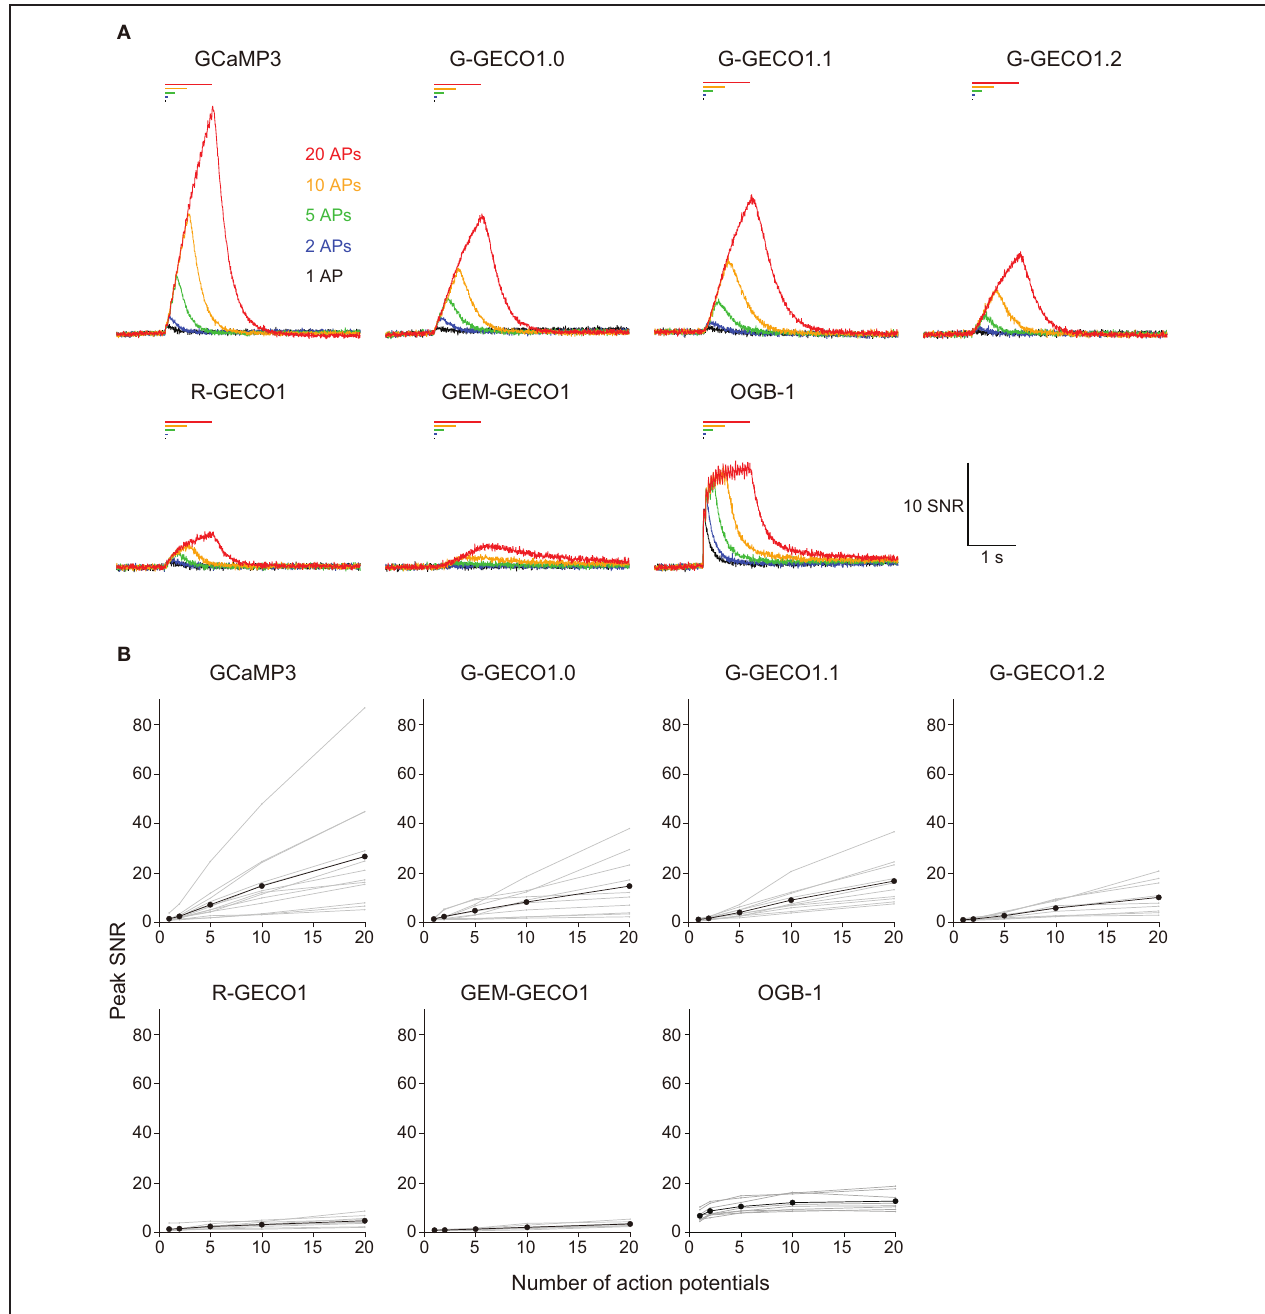
FIGURE 2 | Action potential-evoked responses of GCaMP3, GECOs, and OGB-1 in cortical layer 2/3 pyramidal cells. (A) SNR traces in response to 1 (black), 2 (blue), 5 (green), 10 (orange) and 20 (red) action potentials (APs) evoked at 20Hz. Each trace is the mean across cells ( n = 13 for GCaMP3,